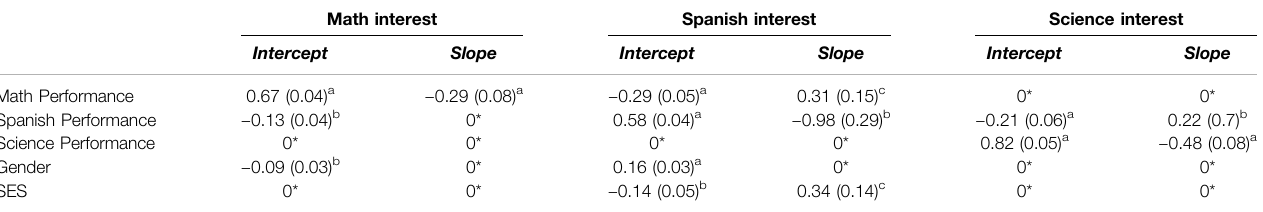
TABLE 4 | Antecedents of the latent growth components of the parallel process LGC model (standardized estimates, standard errors in the parentheses) among Spanish secondary school